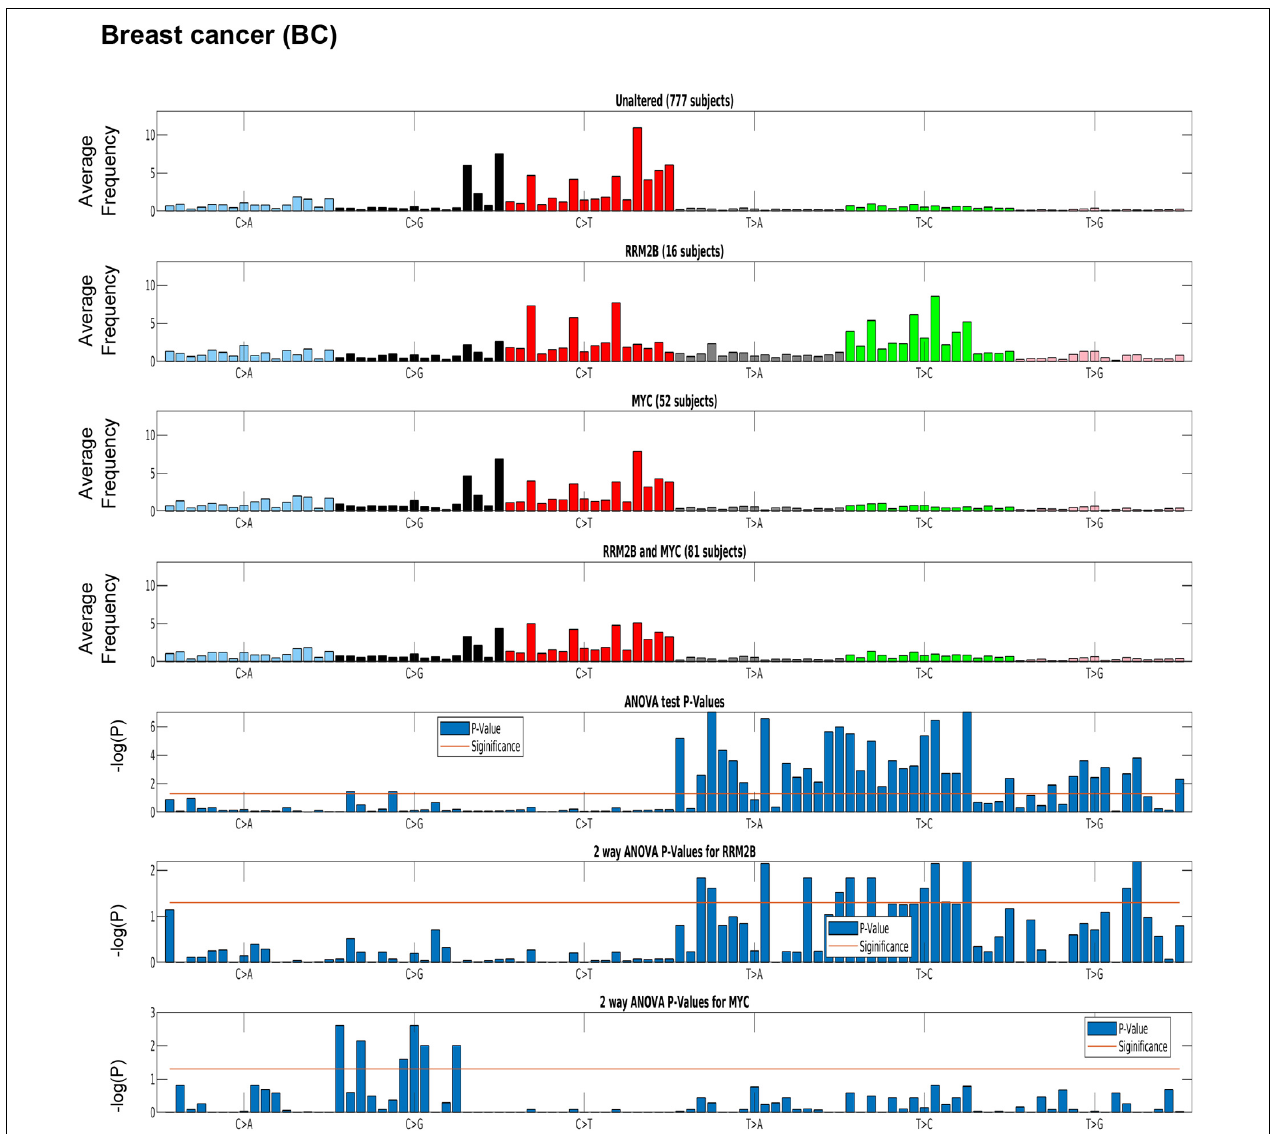
FIGURE 5 | Mutation signature in breast cancer (BC) cases segregated by amplification type. One-way ANOVA ( RRM2B amplifications only vs. other groups) and two-way ANOVA (included group with RRM2B and MYC co-amplifications) analysis showed that the T > C and T > G mutations are statistically significant. Top panels: tumor whole-exome sequence data from the PanCancer Atlas studies was used to calculate the average frequency of the 96 trinucleotide context mutations in each group: unaltered cases, cases with only RRM2B amplifications, cases with only MYC amplifications, and cases with amplifications in both. Bottom panels: The statistical significance of each comparisons is represented by ANOVA tests as -log10 ( P -value) for each of the 96 trinucleotide context mutations. The -log10 (P) visualizations are provided for: one-way ANOVA comparing RRM2B only group to all other groups, a two-way ANOVA comparing all groups with RRM2B or MYC amplifications. -log10 (P)—the taller the bars are, the lower is the P -value and when the bars exceed the red line, P- values are less than 5%. P- values of each subfigure have been corrected using Benjamini–Hochberg